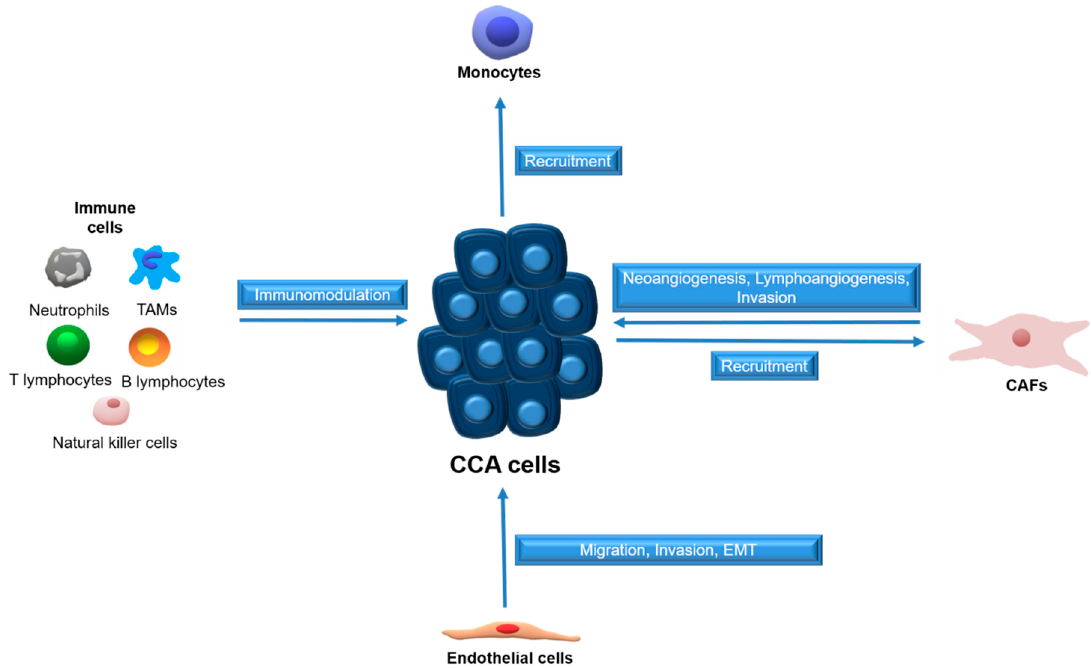
Figure 1. Schematic representation of paracrine effects between stromal cells and CCA cells. Tumor associated macrophages (TAMs), cancer ‐ associated fibroblasts (CAFs), cholangiocarcinoma (CCA).